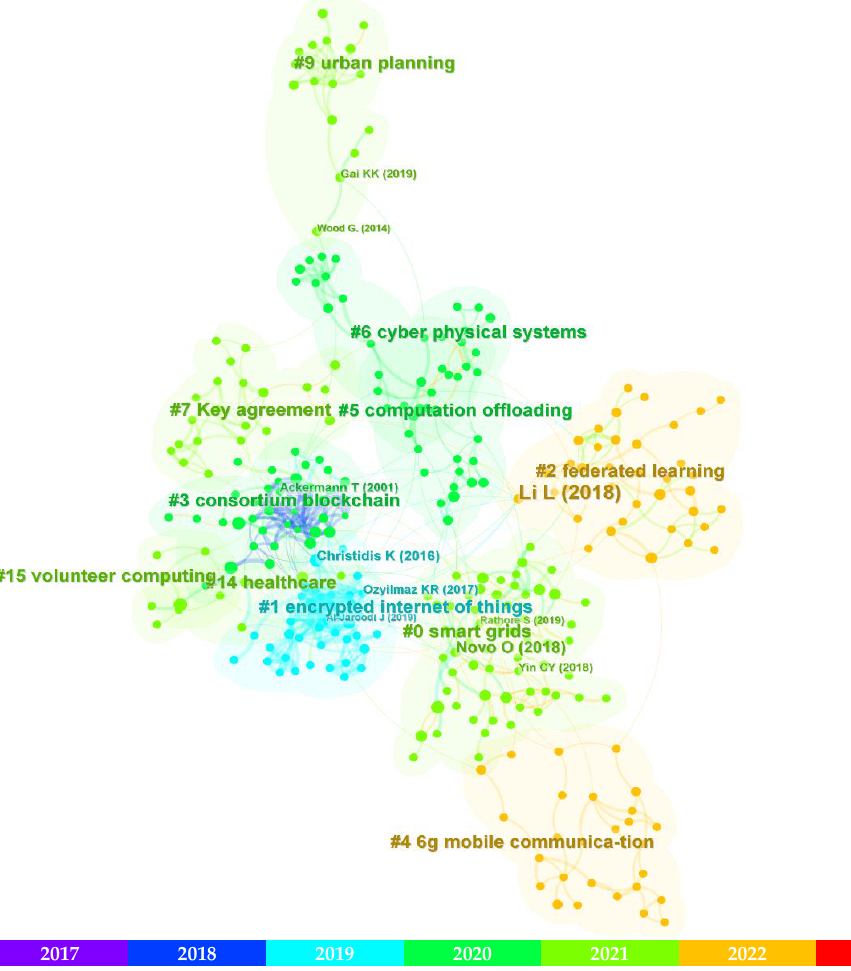
Figure 14. Largest document co-citation clusters in the subject field.